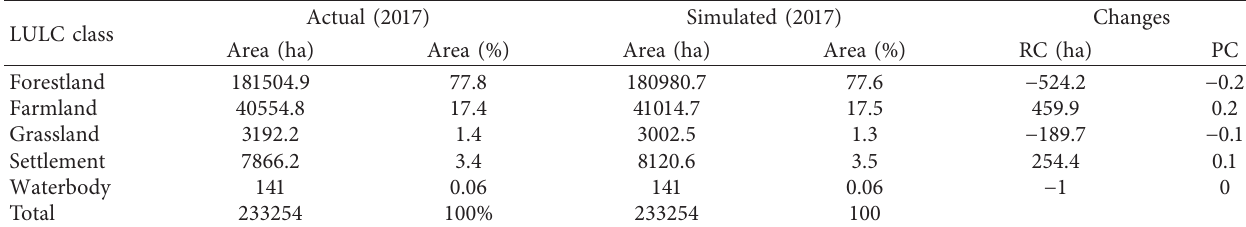
Table 10: Comparison of actual and simulated LULC changes in 2017.